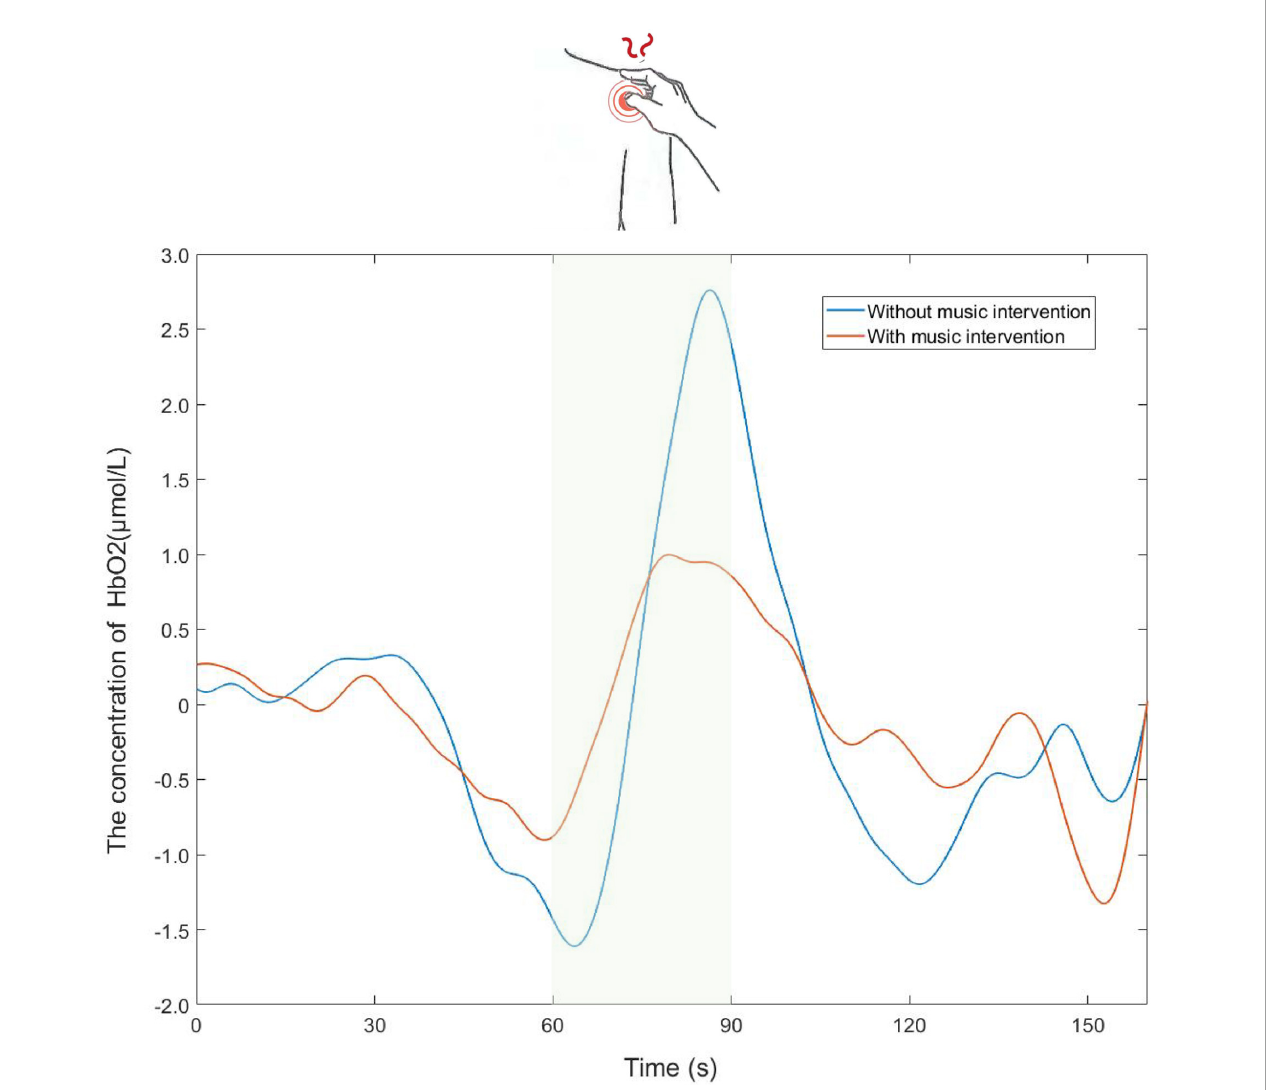
FIGURE3 Partial time series plot of the oxy-hemoglobin ([HbO 2 ]) concentration response of the channels covered by the regions of interest (ROI) brain